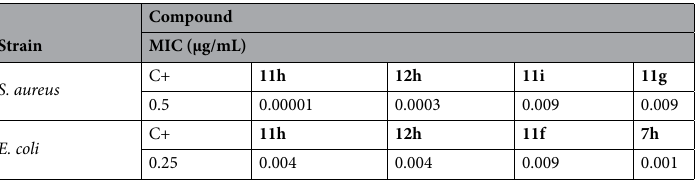
Table 6. The minimum inhibitory concentration (MIC) for the most active hybrid quinoline–imidazole/ benzimidazole compounds ( 11h , 12h , 11i , 11g , 11f , 7h ). S. aureus Staphylococcus. aureus ATCC 25923, E. coli Escherichia coli ATCC 25922 , C+ Gentamicin for S. aureus and E.